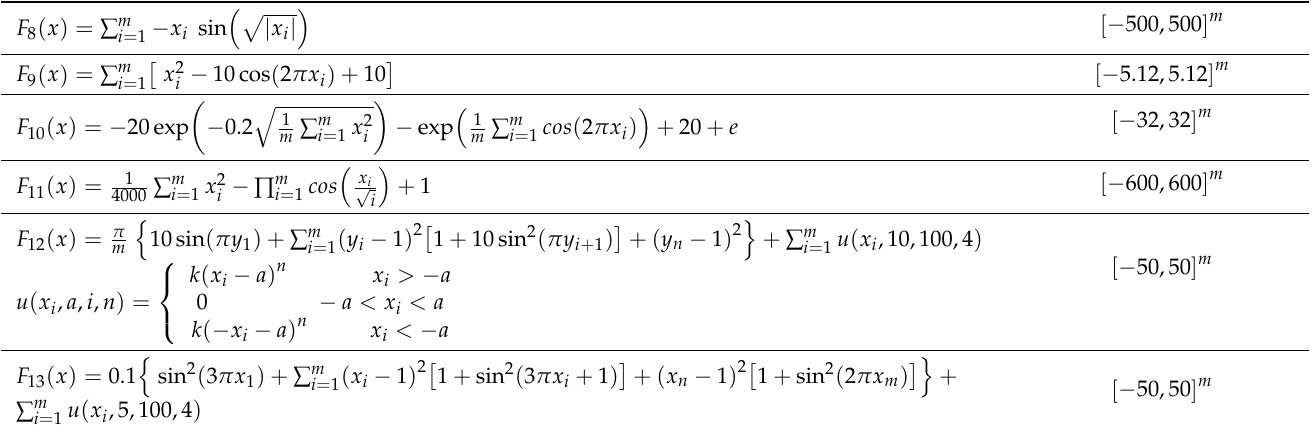
Table 3. Multimodal test